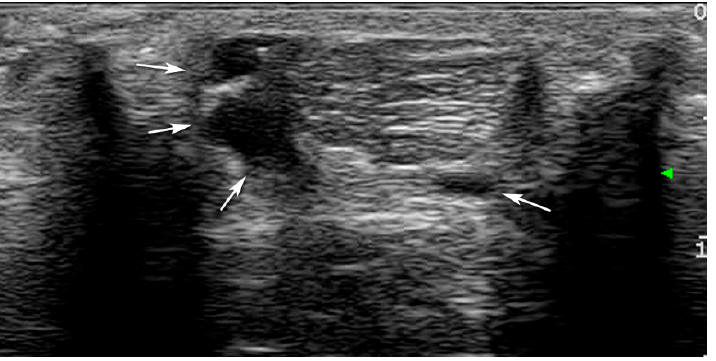
Figure 3. Ultrasonographic features of the induction of the lesion with an injection within the peritendinous space under ultrasound guidance (arrows).